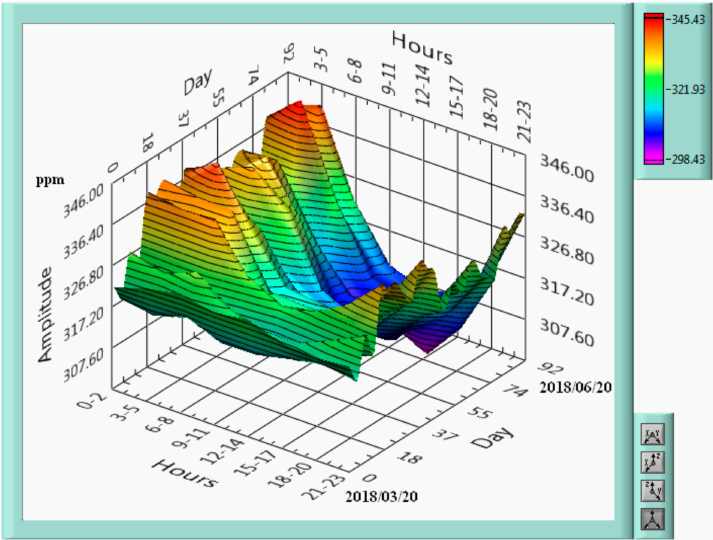
Figure 8. CO 2 in Nehoiu spring